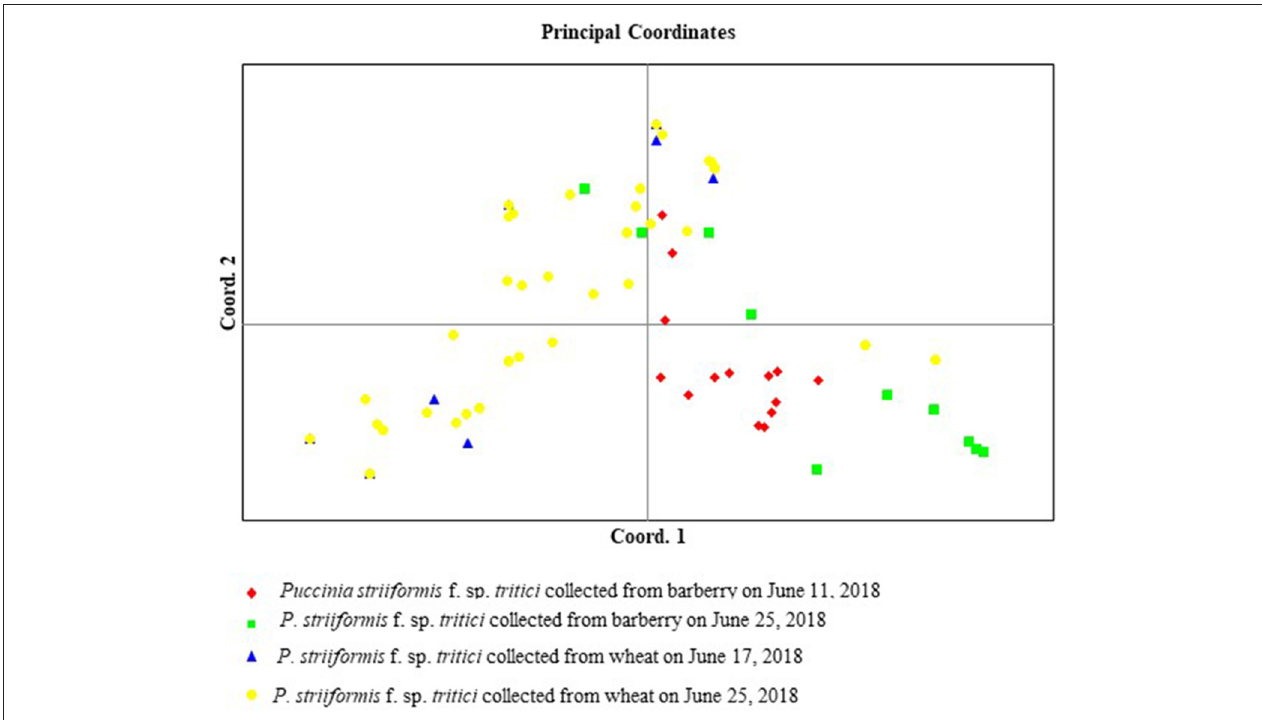
FIGURE 9 | Principal coordinates analysis (PCoA) based on the calculated genetic differences between each of Puccinia striiformis f. sp. tritici isolates. The first axis represents 27.63% and the second represents 23.92% of the total genetic differences between the individual isolates.